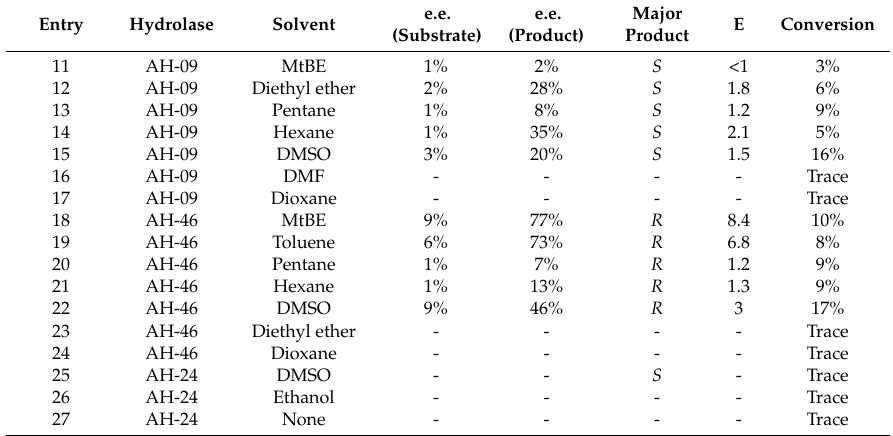
Table 5. Representative results of cosolvent screens of ( rac )- 4 with selected enzymes AH-09, AH-24 and